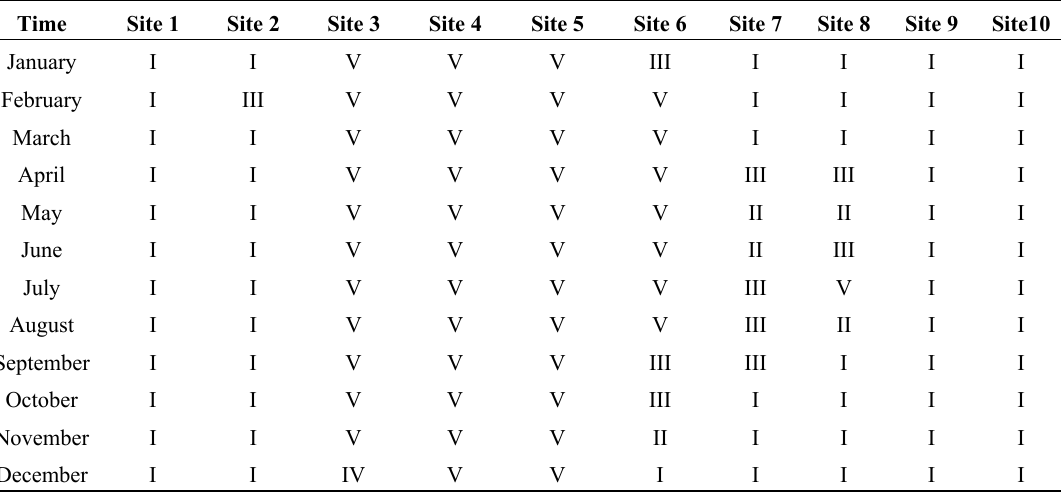
Table 4. Results of water quality